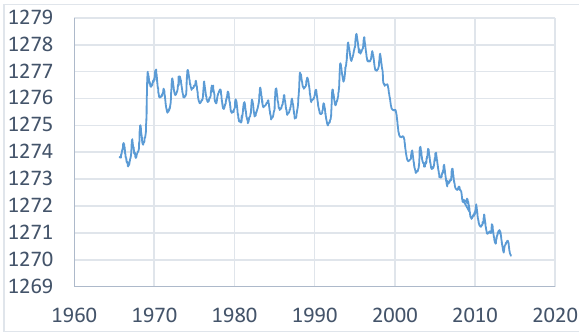
Fig. 2 The flow diagram of the strategy for the Urmia Lake volume